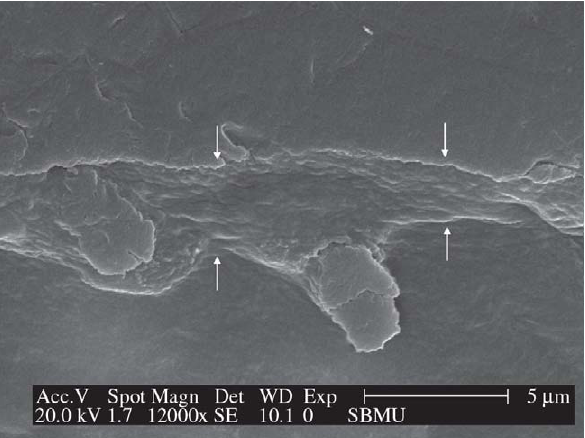
Figure 2. SEM micrograph of resin-dentin interface created by Adper Single Bond. The hybrid layer (arrows) and the resin tag formation can be